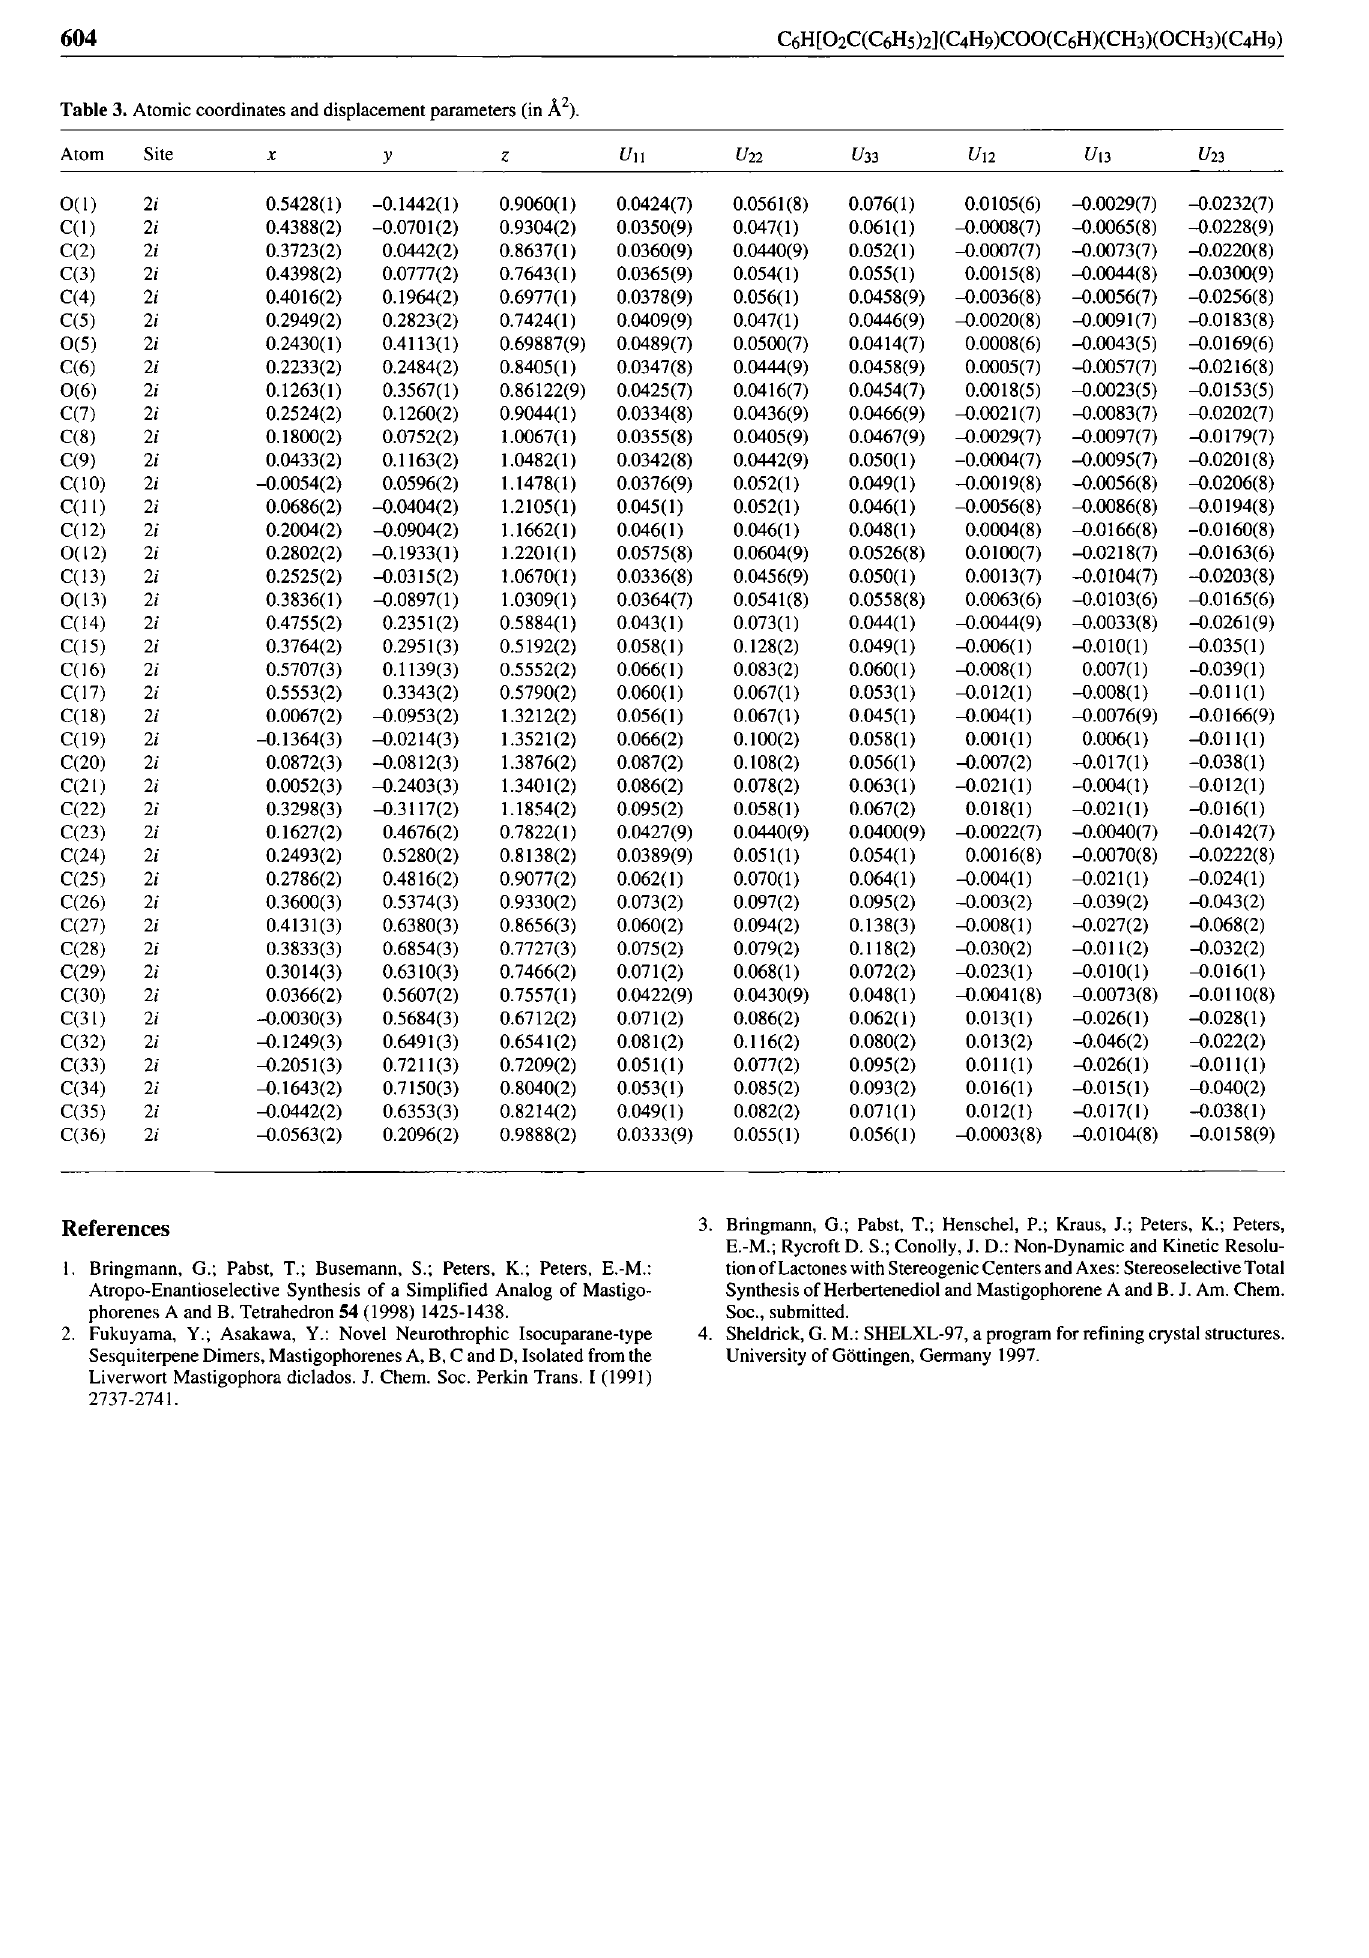
Table 3. Atomic coordinates and displacement parameters (in A 2